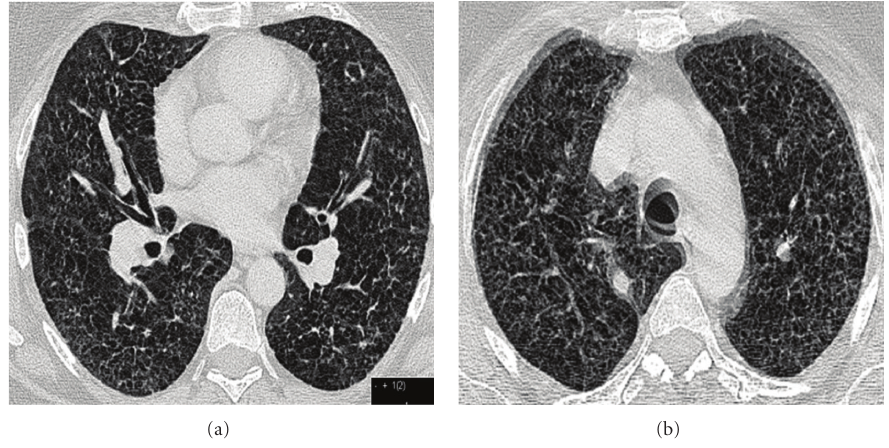
Figure 3: Pulmonary Langerhans cell granulomatosis, computed tomography.